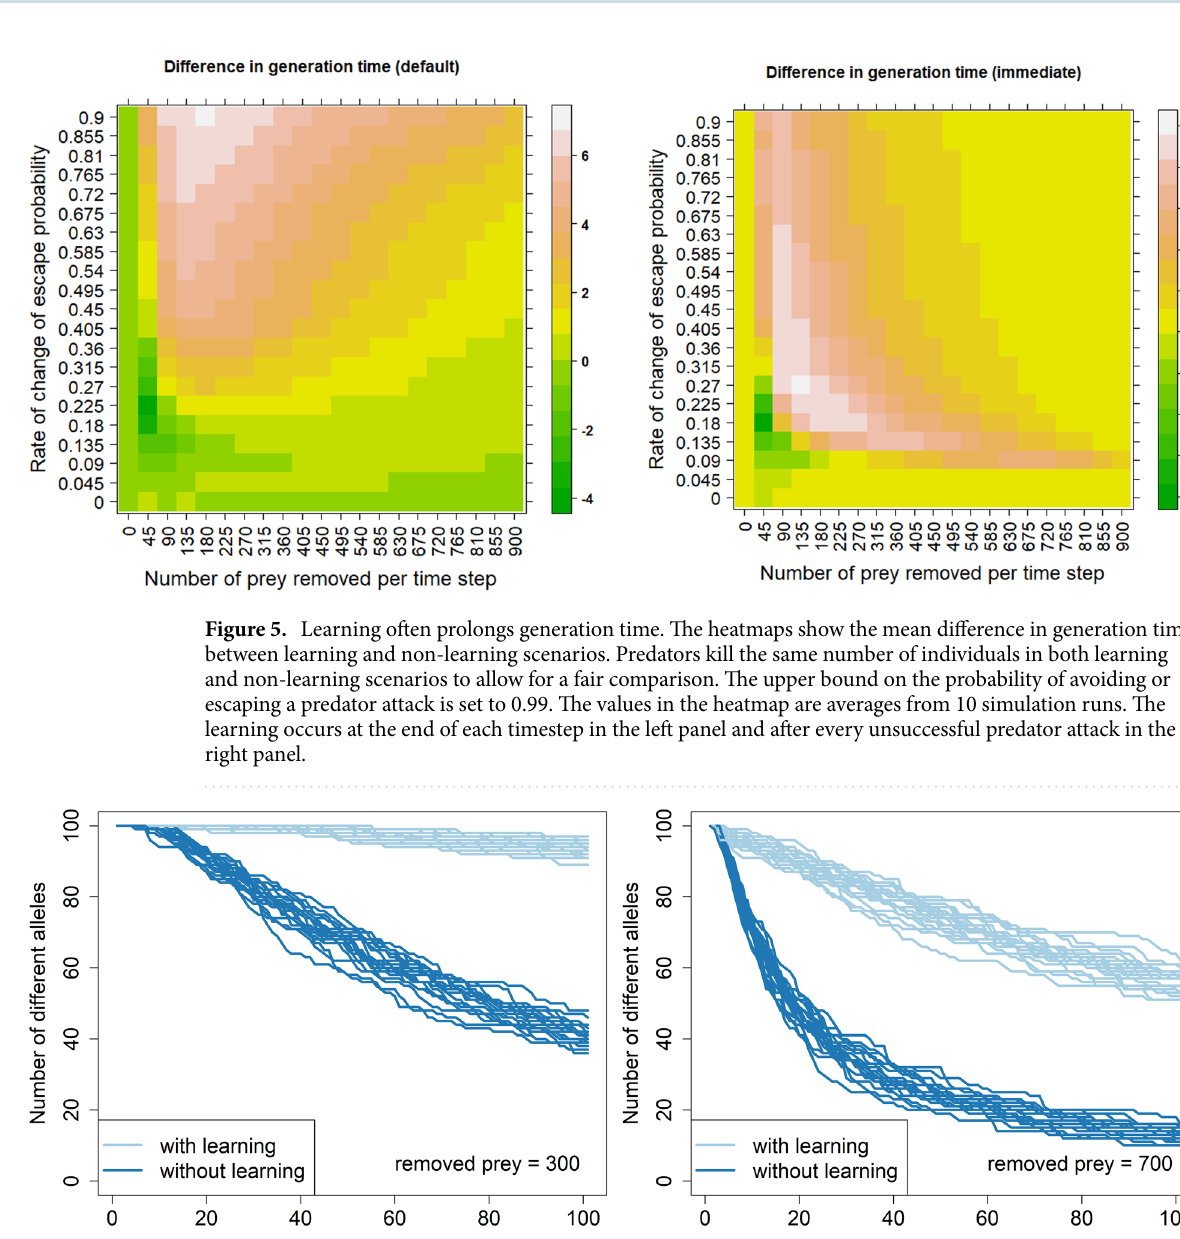
Figure 6. Effect of learning on genetic drift in a diploid sexually reproducing population. Temporal dynamics of the number of alleles present in populations of prey subject to predation. All prey populations consist of 1000 individuals at the beginning of each time step. Individuals killed by predators are replaced at the end of each step through reproduction of surviving individuals ("Methods"). In panel ( a ), predators consume 500 prey individuals per time step, while in panel ( b ), predators consume 800 prey individuals per time step. Predators kill the same number of individuals in both learning and non-learning scenarios to allow for a fair comparison. The upper bound on the probability to avoid or escape predator attack is set to 99% for both panels. Each panel shows ten simulation runs for both learning and non-learning